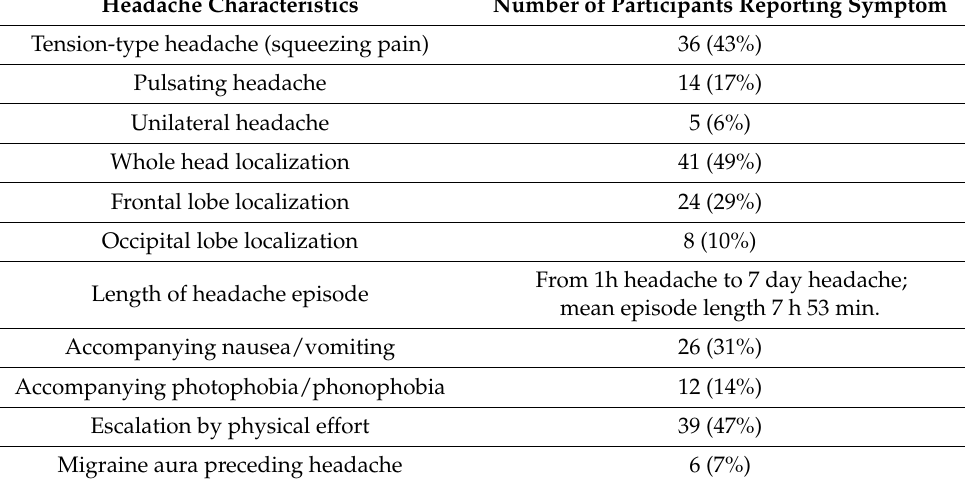
Headache characteristics, accompanying features, and treatment responses of patients